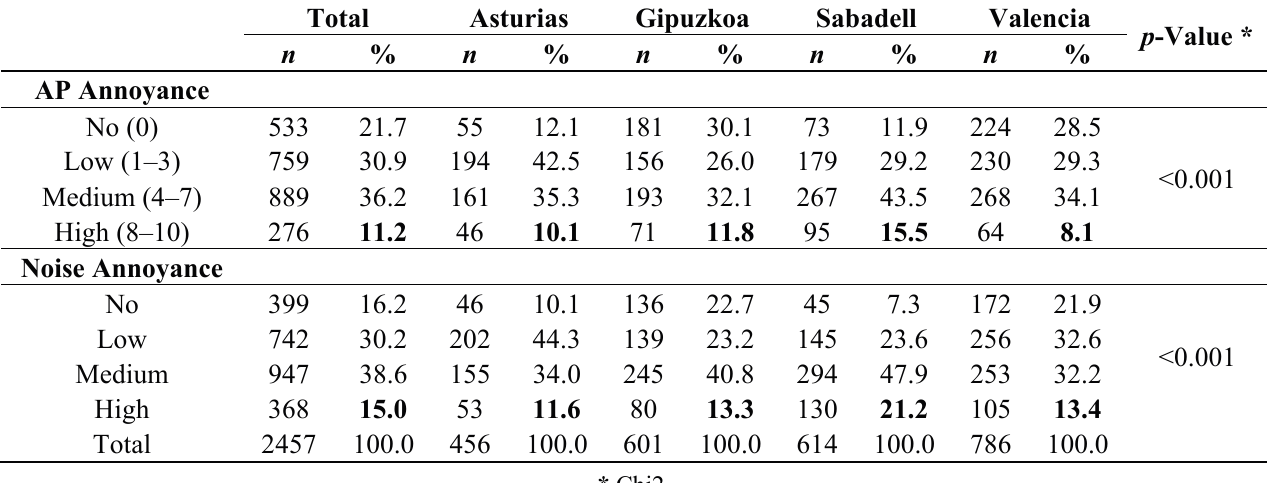
Table 1. Prevalence for each category of annoyance.